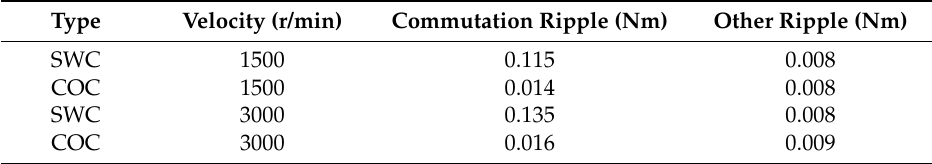
Figure 12. Test waveforms of torque: ( up ) with SWC (red line: 3000 r/min; blue line: 1500 r/min); ( down ) with COC (red line: 3000 r/min; blue line: 1500 r/min). Table 3. Torque ripple comparison of SWC and COC.